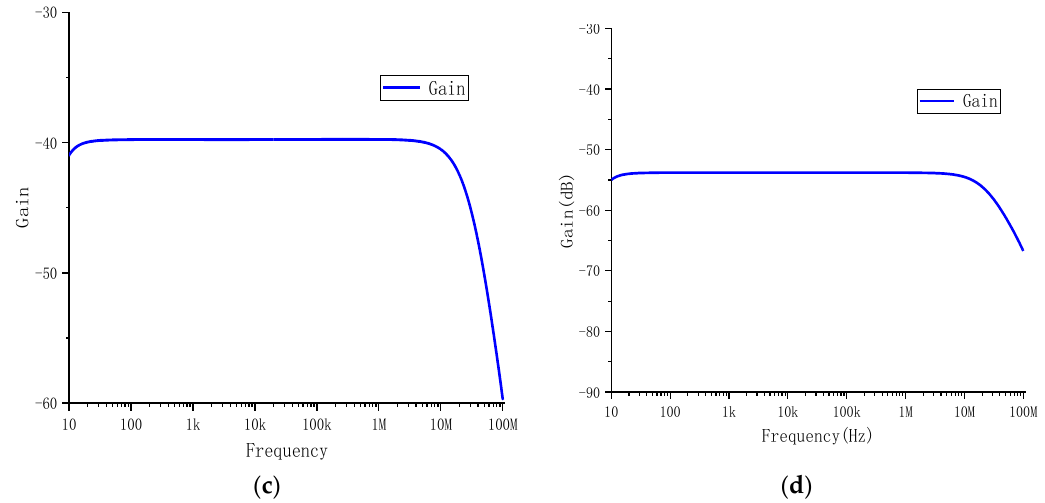
Figure 7. Amplitude – frequency characteristics of the PCB coil sensor: ( a ) amplitude – frequency characteristics, ( b ) amplitude – frequency characteristics with passive integral, ( c ) amplitude – frequency characteristics with active integral and ( d ) overall amplitude – frequency characteristics.